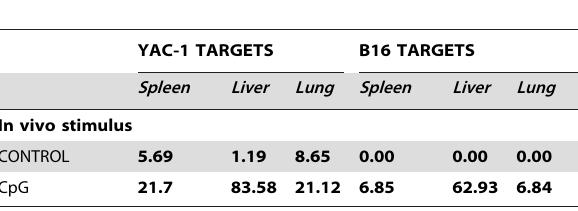
Table 1. Induction of organ-specific cytotoxicity against